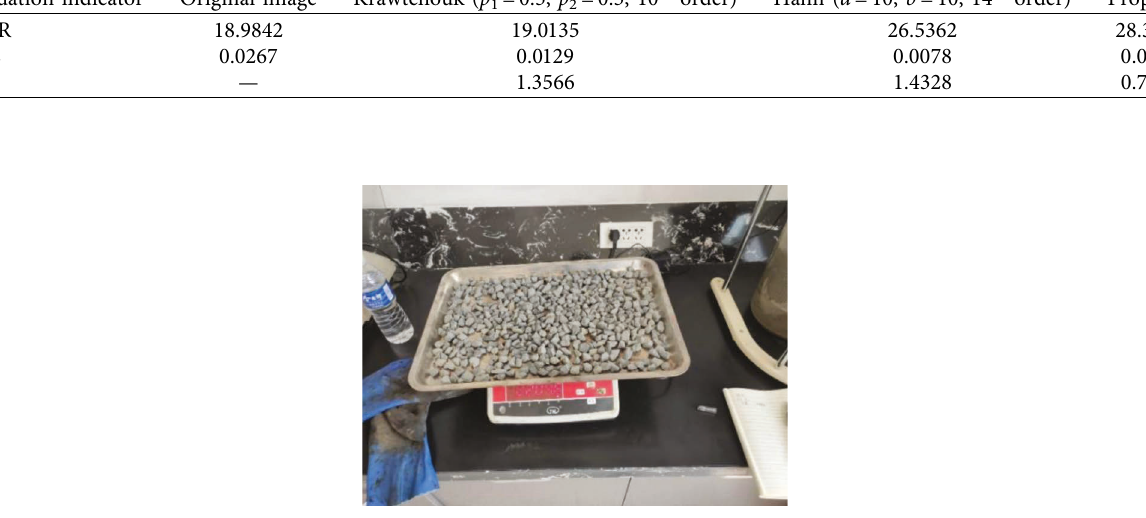
Figure 11: 9.5-13.2 mm indoor gravel weighing. Table 4: Existing method indoor gravel scattering test gravel scattering rate (%).